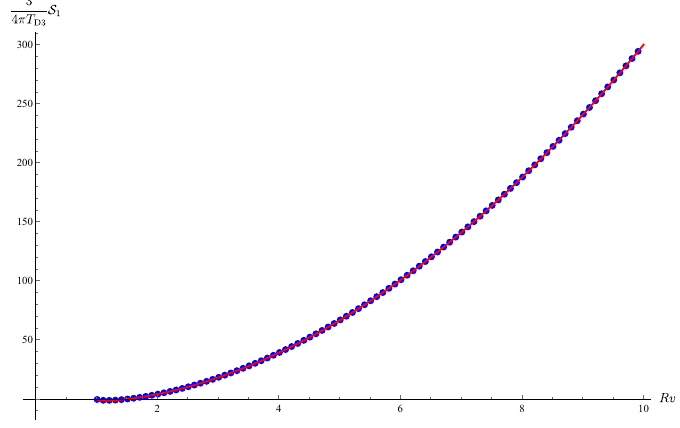
Figure 11 . Comparison between the numerical integration of eq. (C.6) (blue dots) and the analyti- cal expression eq. (C.8) (red curve). The numerical values agree perfectly with the analytical result. found in section 4.3. Concretely, in figure 11 we show the numerical result (blue dots)